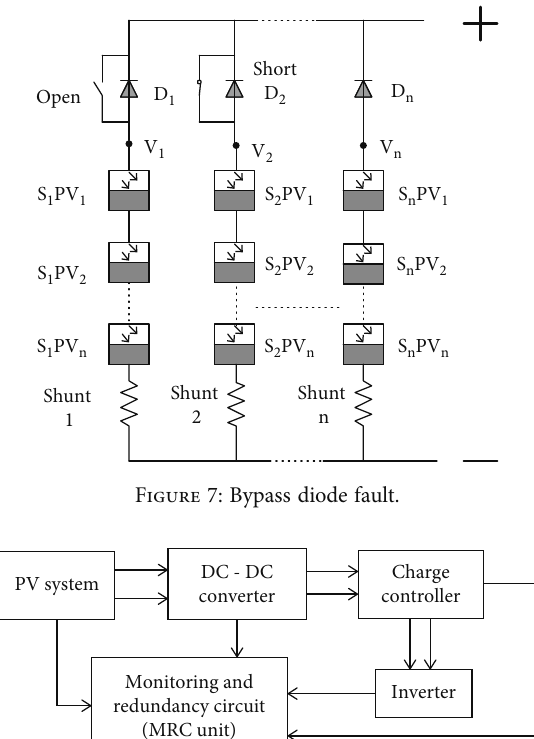
Figure 8: Charge controller fault monitoring